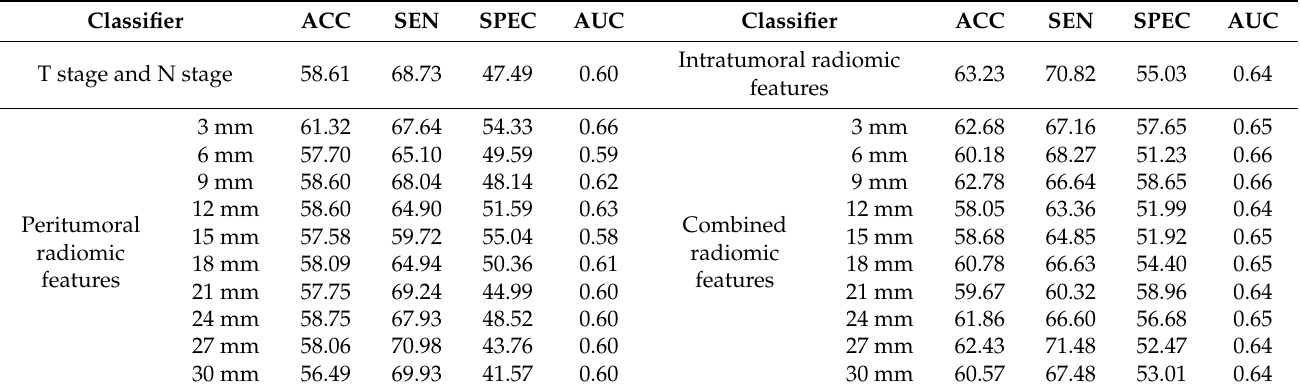
Table 3. Classification performance of radiomic features for 2-year recurrence-free